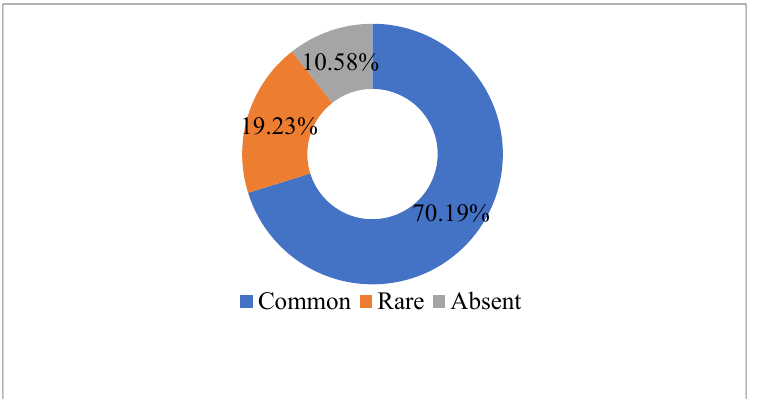
Figure 2. Status of the grey wolf in the study area based on respondents’ views. The categories are based on the wolf sightings by respondents and due to the predation of livestock by wolf that respondents suffered with.